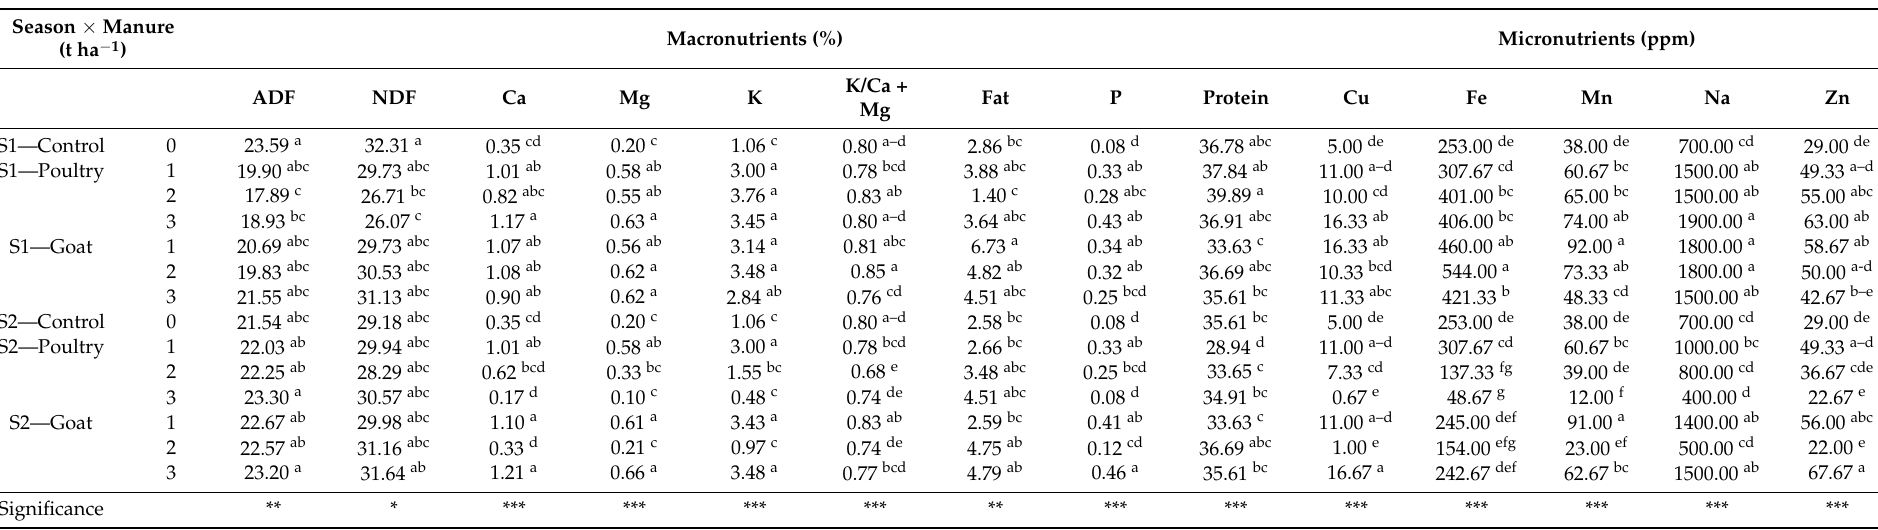
Table 4. Interaction between season and manure on Sesamum alatum nutrient